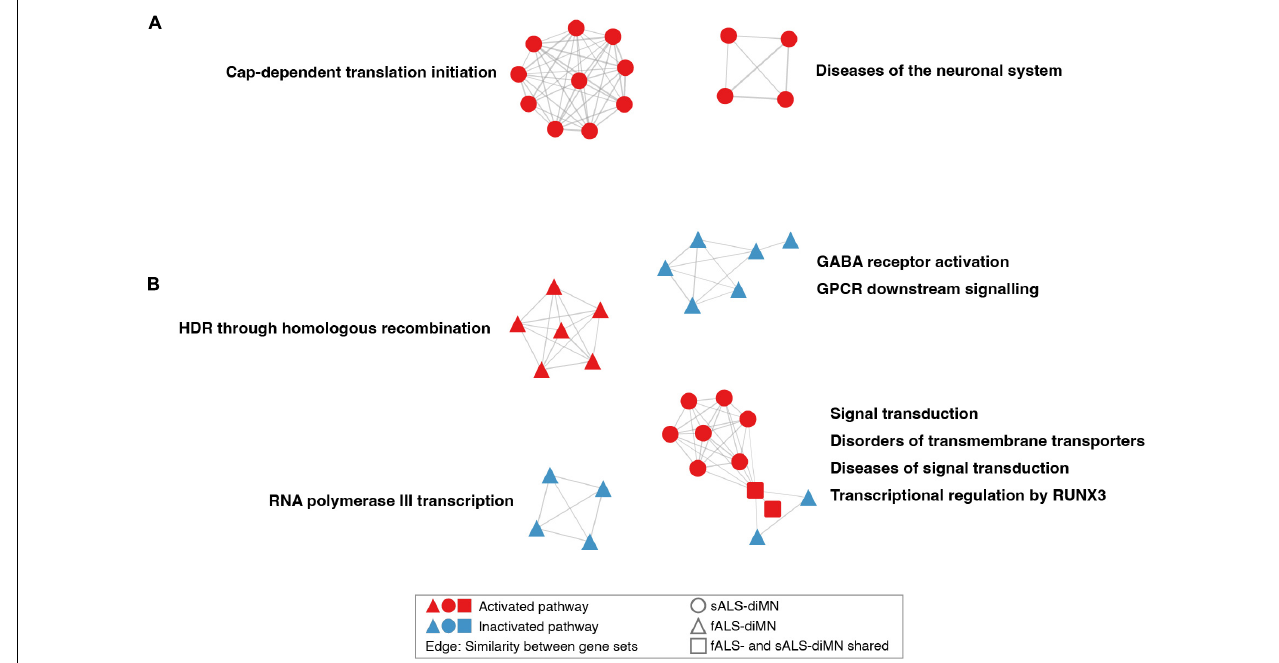
FIGURE 4 | Network of dysregulated pathways in diMN comparisons. Dysregulated pathways based on diMN (A) transcriptomic and (B) proteomic comparisons. Notations refer to Figure 3 . Only clusters containing more than three pathways were